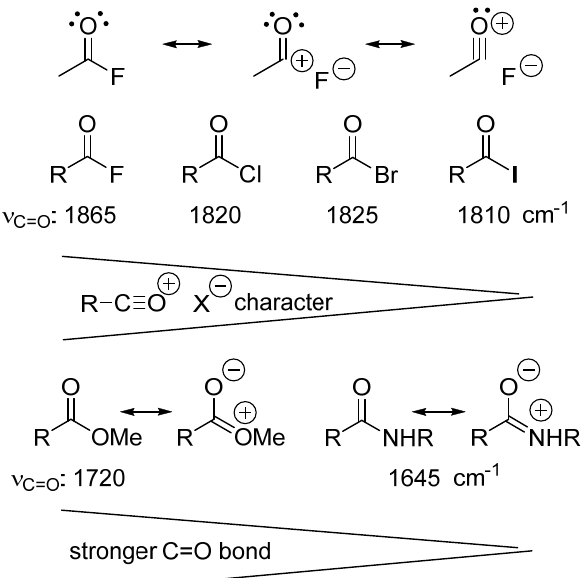
Figure 1. Hyperconjugation in acyl halides (donation from the carbonyl group n(CO : ) non-bonded electron-pairs to the σ (C-X) bond) competes with the n(X : )/ π (C=O) conjugation. This competition exists also in carboxylic esters and carboxamides. Reprinted with permission from Ref. [17]. Copyright 2019 Wiley.